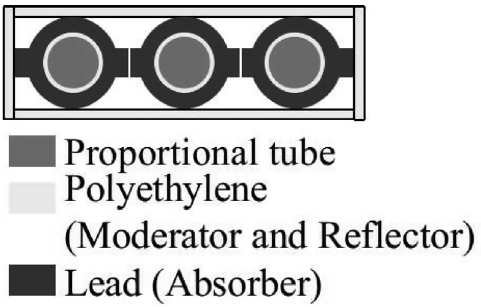
Fig. 4. Schematic view of a